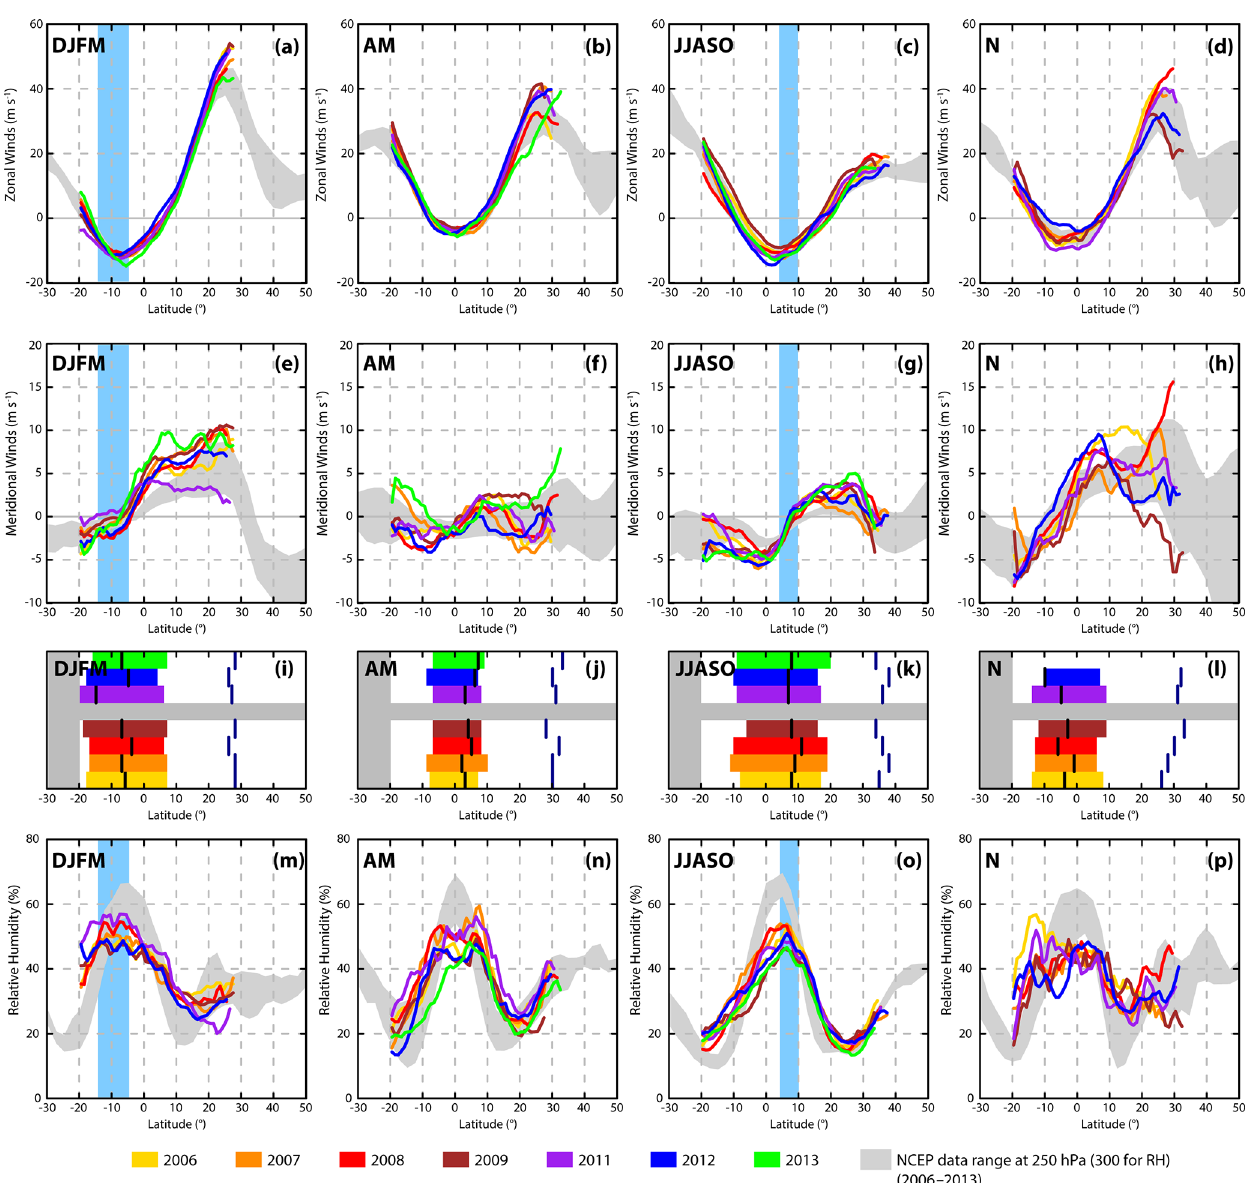
Figure 2. IAGOS meridional and seasonal transects of zonal winds (a–d) , meridional winds (e–h) and relative humidity (m–p) . Panels (i) – (l) are schematic representations of average easterly winds zone latitudes (colored rectangles), average latitude of meridional wind divergence (black lines), and average latitude of the intersection between flight trajectories and the tropopause (northern limit of tropospheric measure- ments). The vertical blue shaded areas represent the deduced ITCZ position. The grey areas represent the NCEP data range at 250hPa for the winds and 300hPa for relative humidity on the flight trajectories for the 2006 to 2013 period.